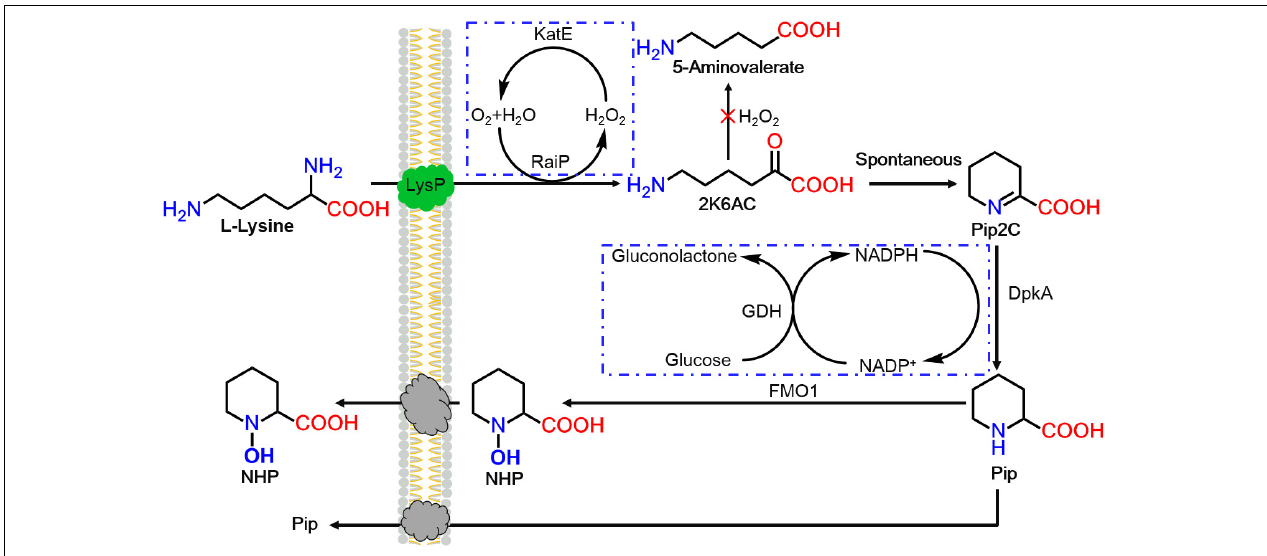
FIGURE 1 | The heterogeneous pathway for N -hydroxy-pipecolic acid (NHP) production from lysine in Escherichia coli . 2K6AC, 2-keto-6-aminocaproate.